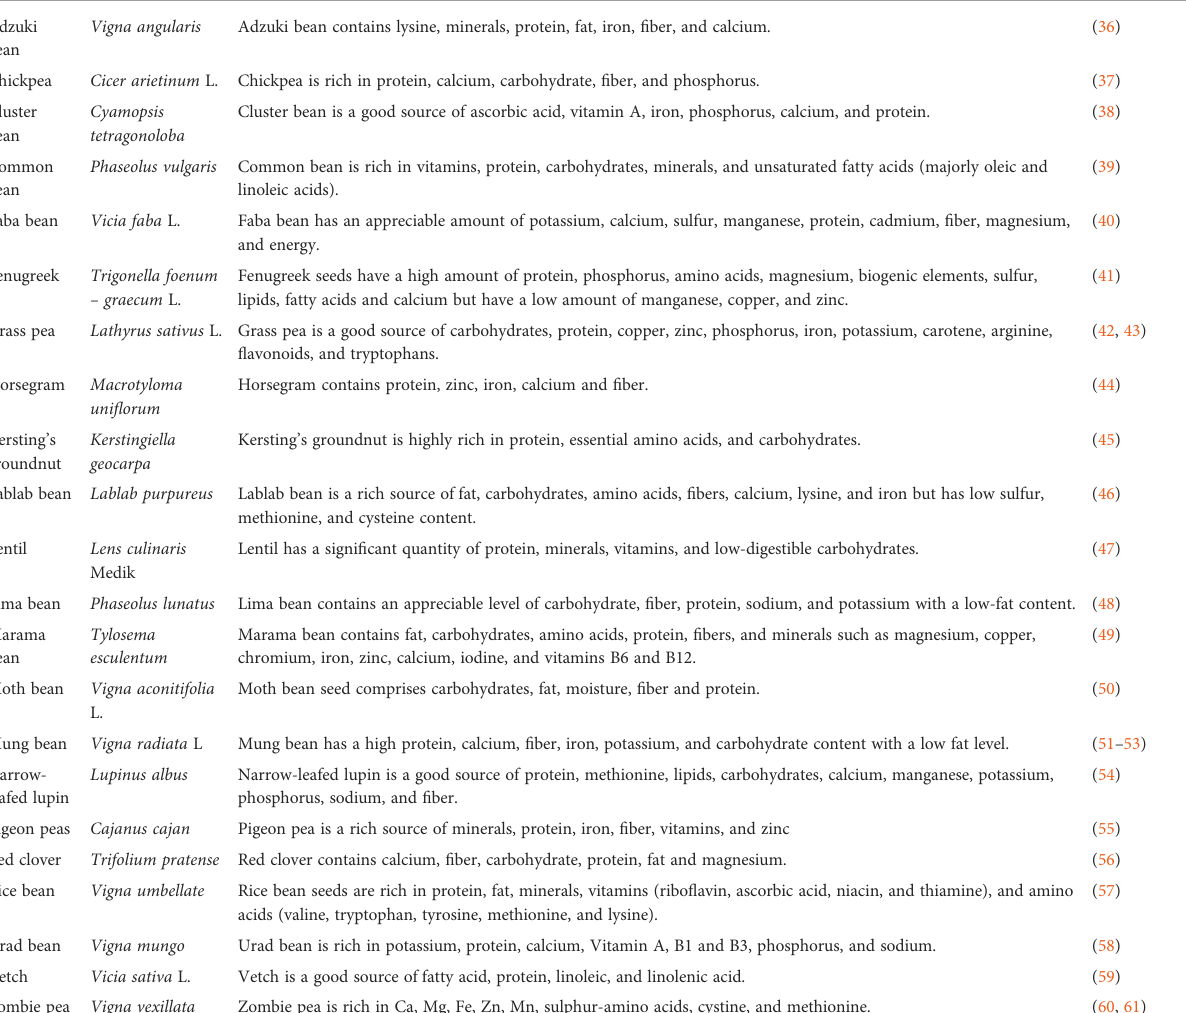
TABLE 1 Underutilized legumes and their nutritional